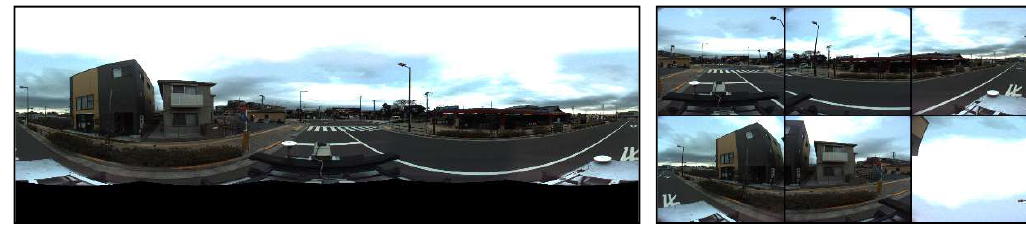
Figure 8. Six fisheye lenses and the stitched panoramic images captured by the Ladybug 3 camera.